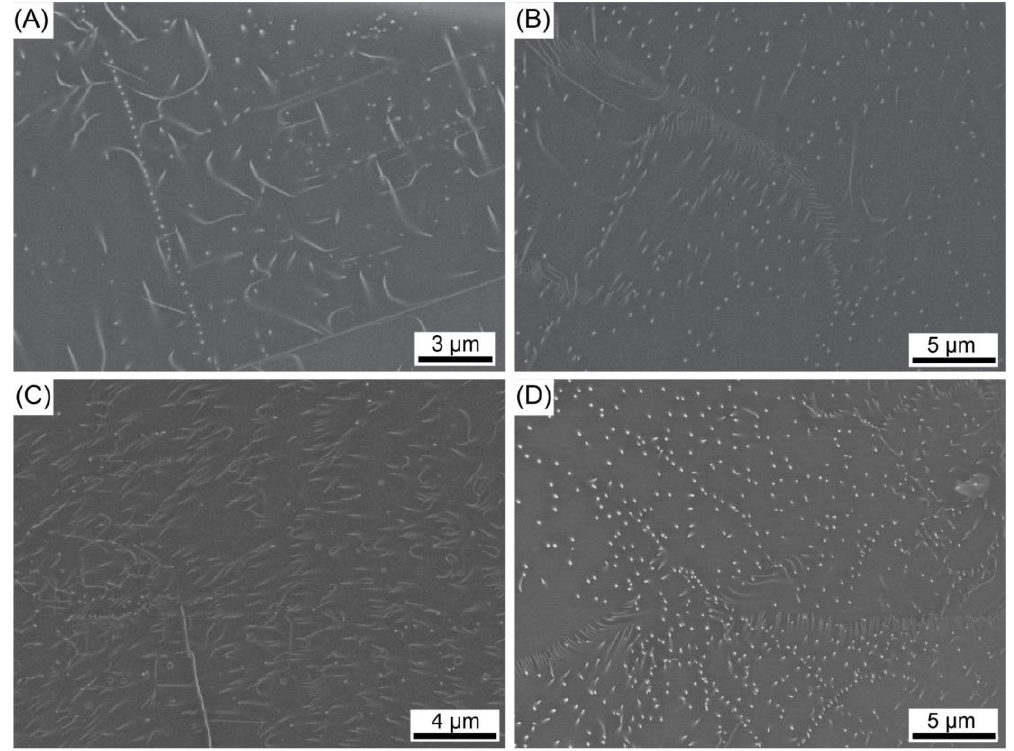
Figure 8. Backscattered electron images showing dislocation microstructures of olivine from ( A ) sample 426, ( B ) sample 429, ( C ) sample 447, and ( D ) sample 448. Dislocations are shown as white dots and lines.